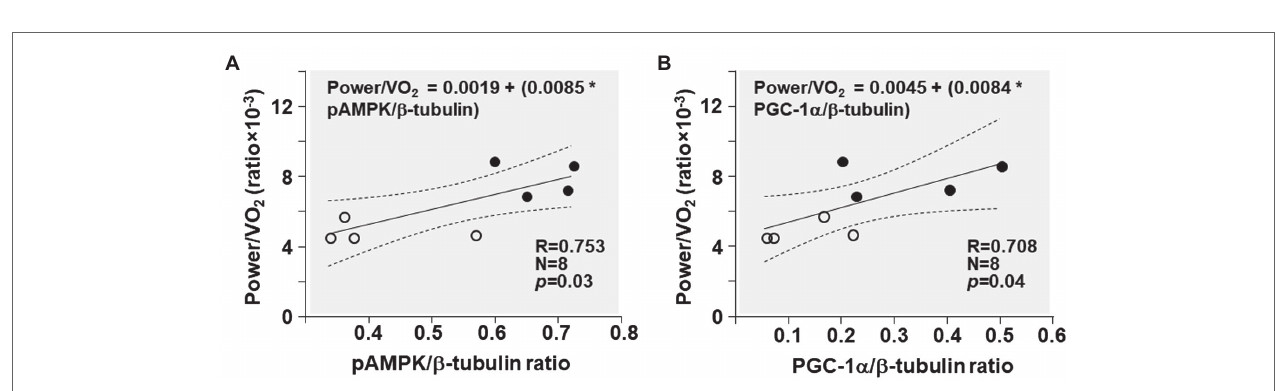
FIGURE 7 | Shown are the relationships between (A) pAMPK/ β -tubulin ratio and power/VO 2 ratio and (B) PGC-1 α / β -tubulin ratio and power/VO 2 ratio in CKO mice (black circles) and controls (white circles). The regression line is shown with the corresponding 95% confidence